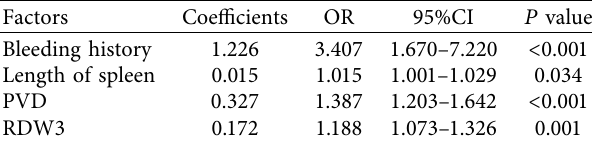
Table 2: Multivariable logistic regression.